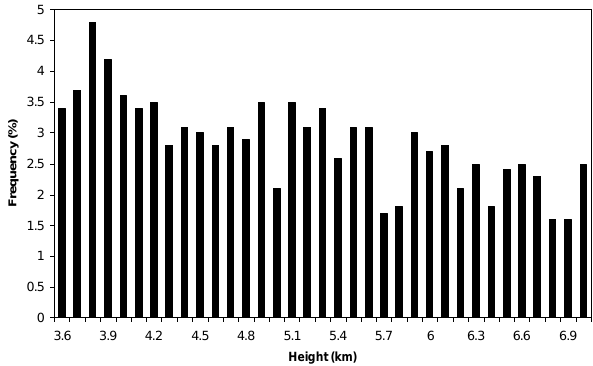
Fig. 12. Column height sampled for the eruption range scenario of Figure 12. Column height sampled for the Eruption Range Scenario of long-lived eruptions (ERS- 687 long-lived eruptions (ERS-WLL). WLL). 688